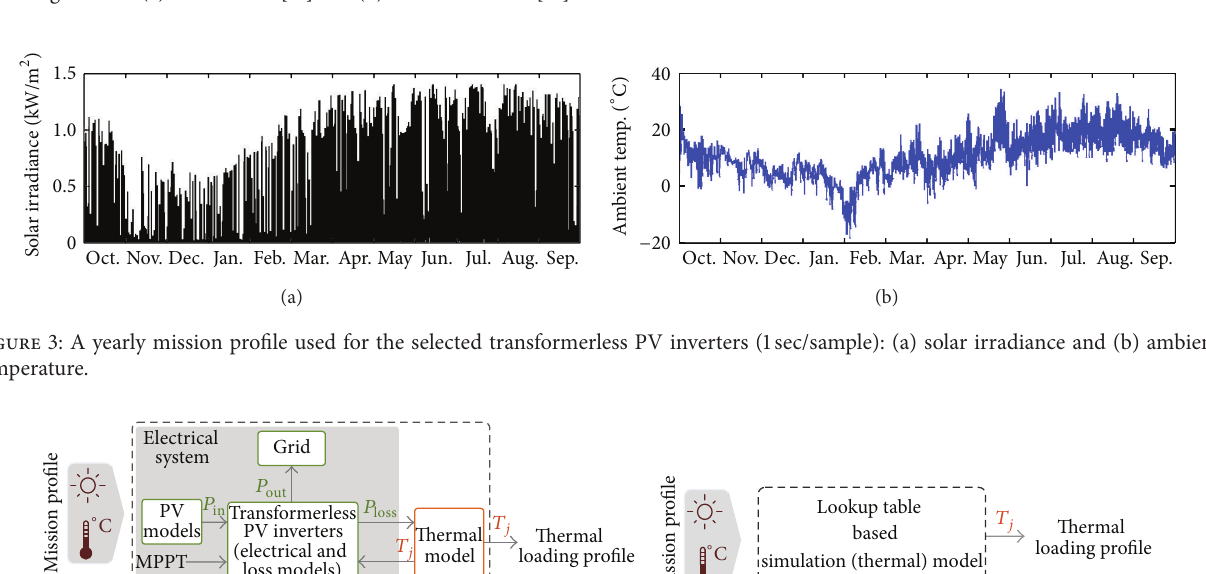
Figure 2: Examples of single-phase transformerless PV inverters derived from the single-phase full-bridge topology by adding extra power switching devices: (a) H6 inverter [13] and (b) HERIC inverter [14].